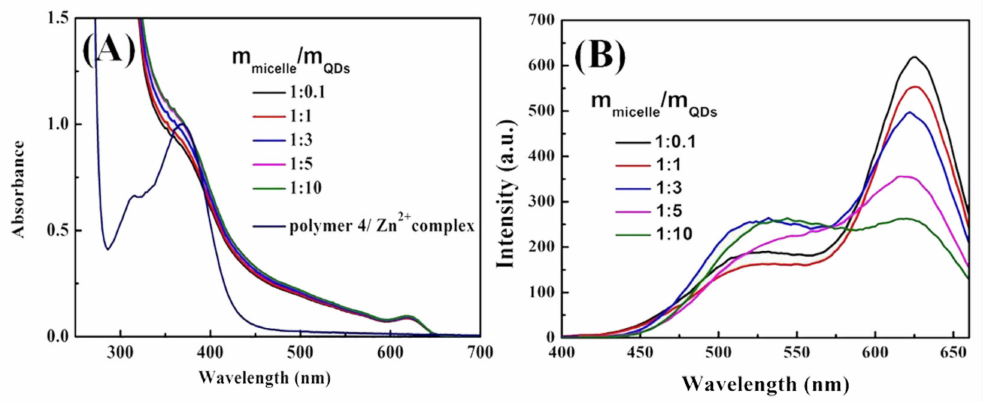
Figure 4. ( A ) UV–Vis absorption spectra and ( B ) PL spectra of CdSe / ZnS@M4-1 with di ff erent M4-1 / QDs ratio from 1:0.1 to